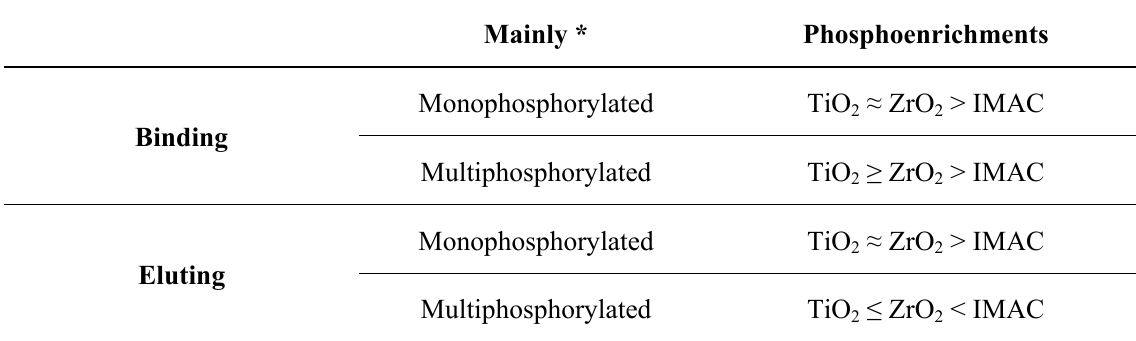
Table 2. While titanium dioxide (TiO ) and zirconium oxide (ZrO ) mainly elute 2 2 monophosphorylated peptides, immobilized metal affinity chromatography (IMAC) chiefly elutes multiphosphorylated peptides. The enrichment process consists of several steps which include: incubation (binding), washing to remove non-specific peptides, and elution of phosopeptides. These steps depend on: the buffer, material of solid support as well as the concentration of the sample.